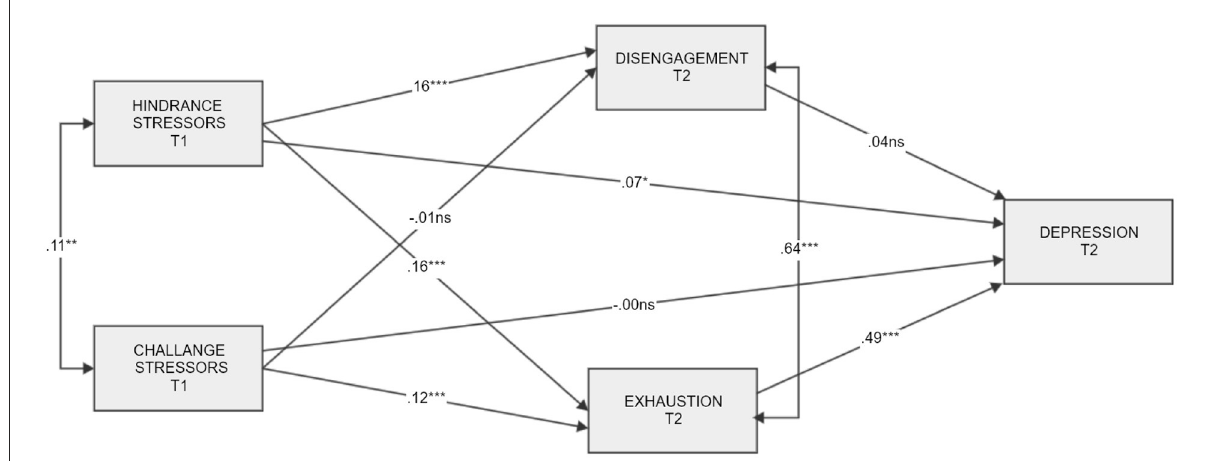
FIGURE1 Hypothesized “just-identified” model of hindrance stressors and challenge stressors in time 1 as predictors of depression in time 2 mediated by burnout levels. Standardized coefficients are presented. “T”, time. * p < 0.05, ** p < 0.01, *** p < 0.001.